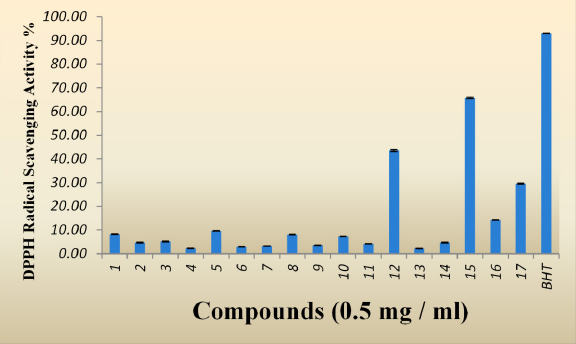
Each value is expressed as mean ± SD (n = 3). Figure: 1: DPPH free radical scavenging activity of compounds 1 - 17.